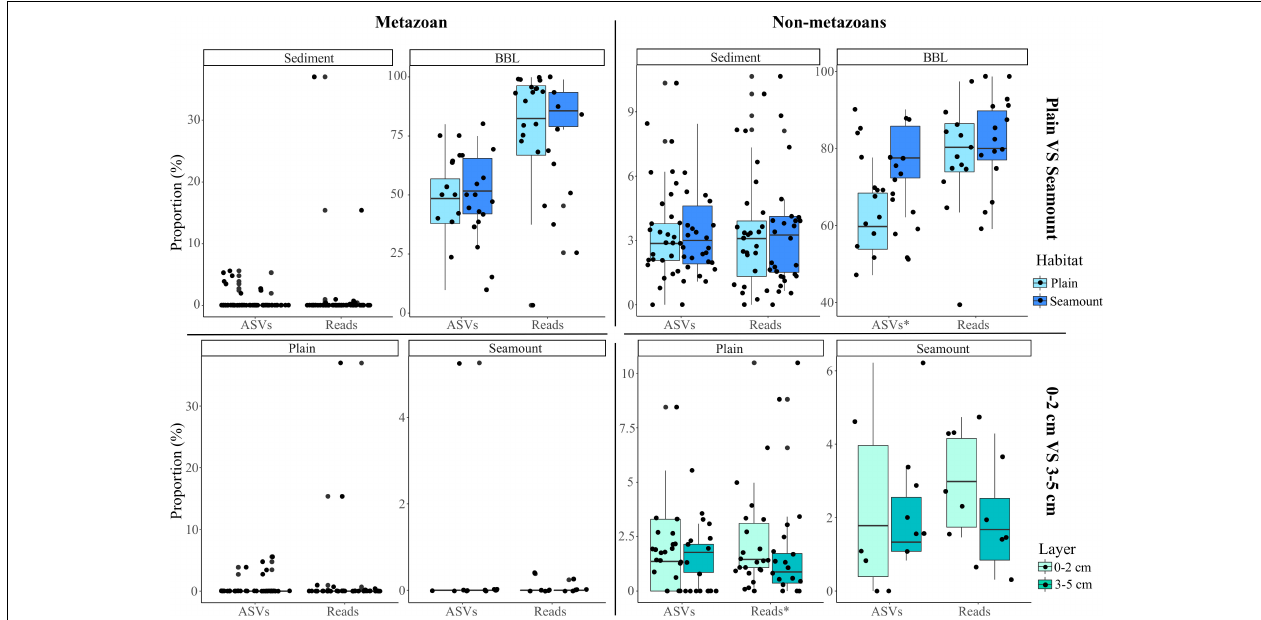
FIGURE 5 | Box-plots of the mean proportion of amplicon sequence variants (ASVs) and their respective reads that derive from pelagic ecosystems (surface to bathypelagic depths) that were sampled at the seafloor across habitats (abyssal plain, seamount) and sediment layers (0–2 and 3–5 cm) for both metazoans and non-metazoans. Plot shows the benthic perspective, or pelagic diversity sampled at the seafloor relative to all diversity sampled at the seafloor. The stars ( x -axis labels) indicate significant differences determined by two-sample Wilcoxon tests.